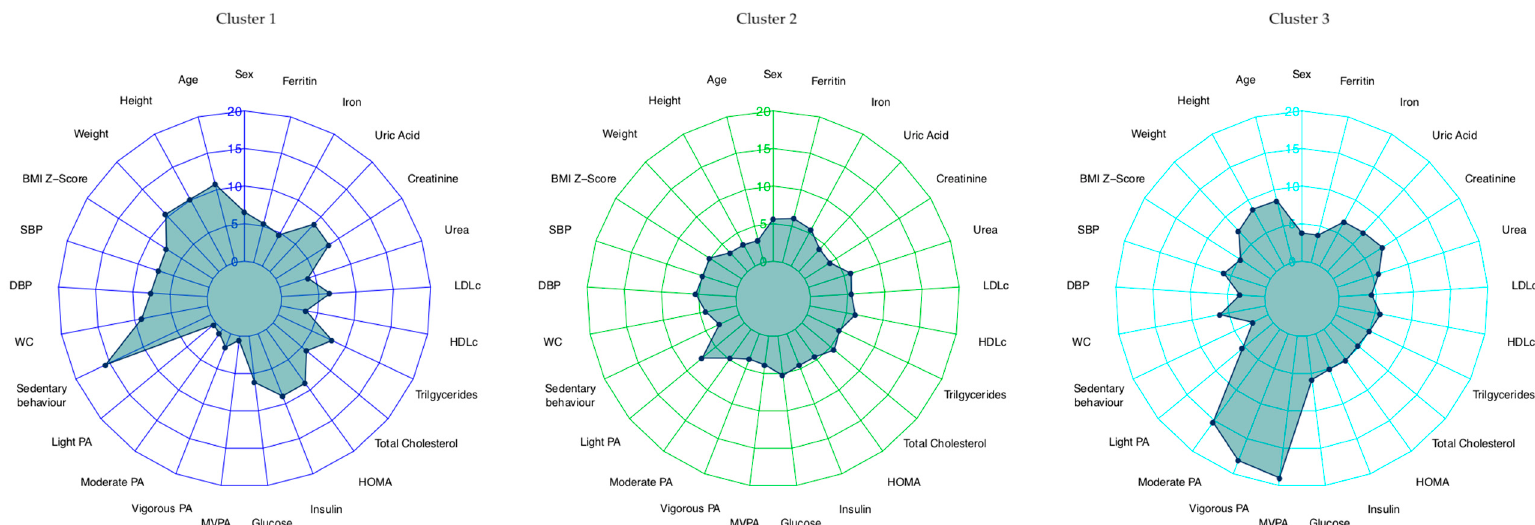
Figure 1. Cluster characteristics based on the measurement of physical activity (cluster 1, cluster 2, cluster 3). DBP: diastolic blood pressure; HOMA-IR: homeostatic model assessment insulin resistance; HDL-c: high-density lipoprotein cholesterol; LDL-c: low-density lipoprotein cholesterol; MVPA: moderate–vigorous physical activity; PA: physical activity; SBP: systolic blood pressure; TAG: triacylglycerides; WC: waist